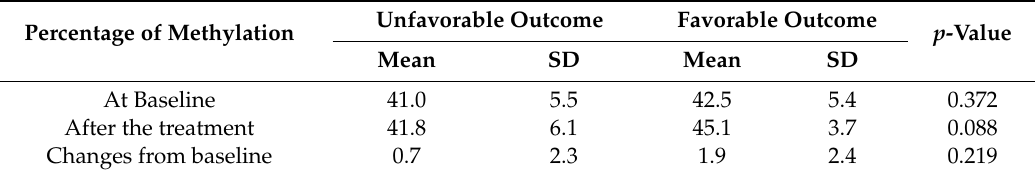
Table 3. Methylation analysis of BDNF rs6265 SNP: comparison of methylation percentages in patients with or without a favorable outcome, together with the results of the statistical analysis (Welch’s unpaired t -test) .